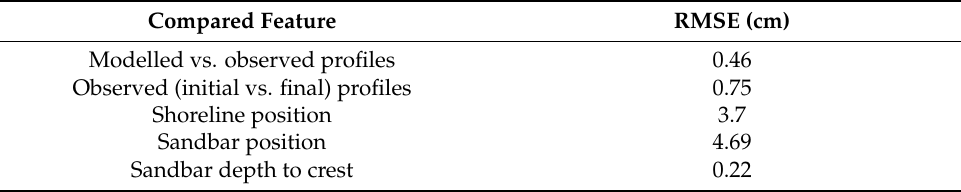
Figure 13. Comparison between the modelled (thick black) and observed mean beach (dashed red line) profile when equilibrium is reached at t = 6 h. Original formulation (top panel, ( a )) and with shift in the location of the transport maxima (bottom panel, ( b )). Table 3. Root mean square error between the final observed and modelled beach profile and between the observed and modelled beach features for all profiles for the accretive case B. Errors are calculated within the active transport zone (i.e., from depth of closure to the run up limit for the erosive wave